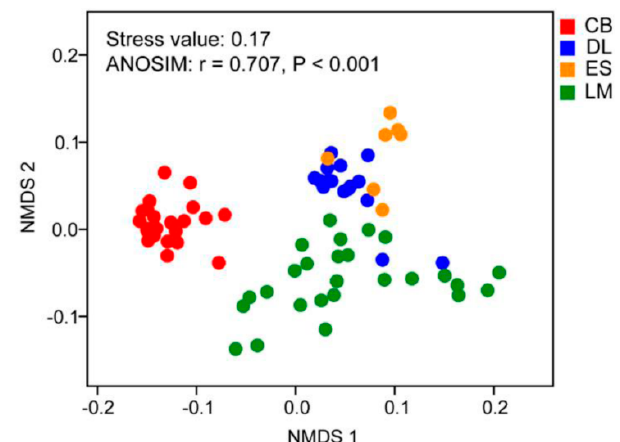
Figure 2. Figure 2. NMDS of Bray–Curtis similarity matrix of soil myxobacterial community from subtropical and tropical forest soil based on amplicon sequence variants (ASV) abundance. Stress value and analysis of similarity are shown in the upper left of the graph. CB, Chebaling (subtropical forest soil); DL, Diaoluoshan (tropical forest soil); ES, Esongling (tropical forest soil); LM, Limushan (tropical forest soil).